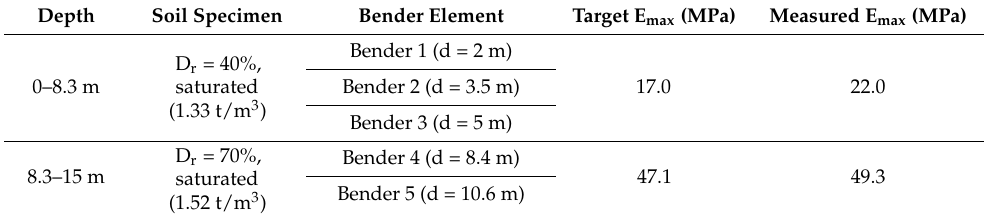
Figure 4. Soil stiffness with depth calculated by the bender element test. Table 3. Depths of bender elements and measured E max (in